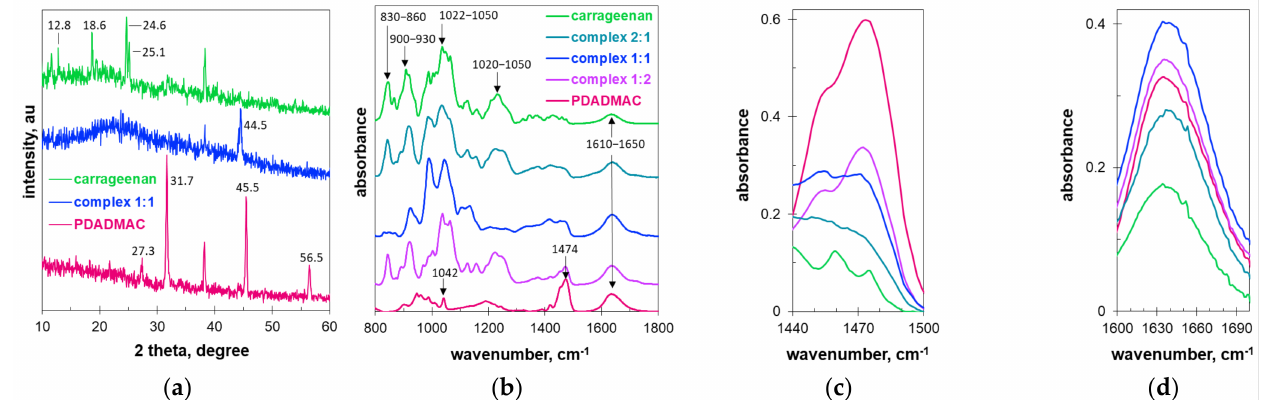
Figure 1. ( a ) XRD patterns and ( b – d ) FTIR spectra of the initial polymers and the formed complexes. The molar ratios of polyDADMAC to carrageenan in the initial solution are indicated. The colors of the lines in subfigures ( c , d ) correspond to the colors in subfigures ( a , b